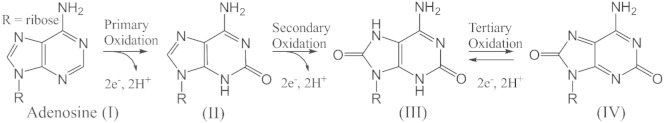
Oxidation mechanism of adenosine. Adenosine undergoes a three sequential, 2-electron oxidations. The first two oxidations are observed using FSCV and are irreversible. R is a ribose unit.